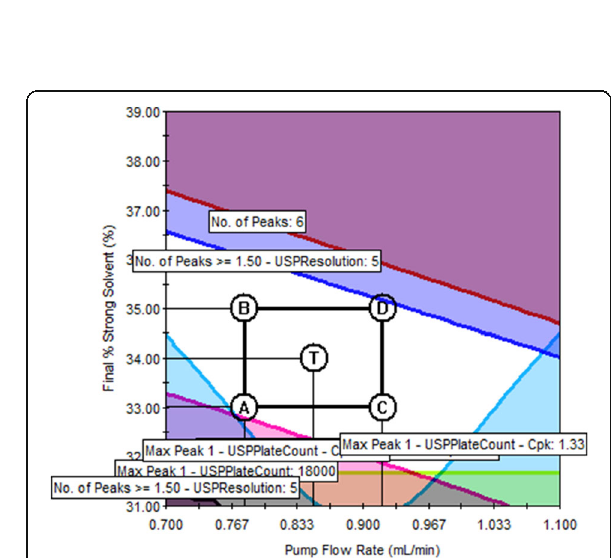
Fig. 7 Single overlay graph shows a much more robust method at point T (pump flow rate = 0.78 mL/min; final % strong solvent = 34.2%; oven temperature = 30.8 °C; EDTA concentration = 0.42